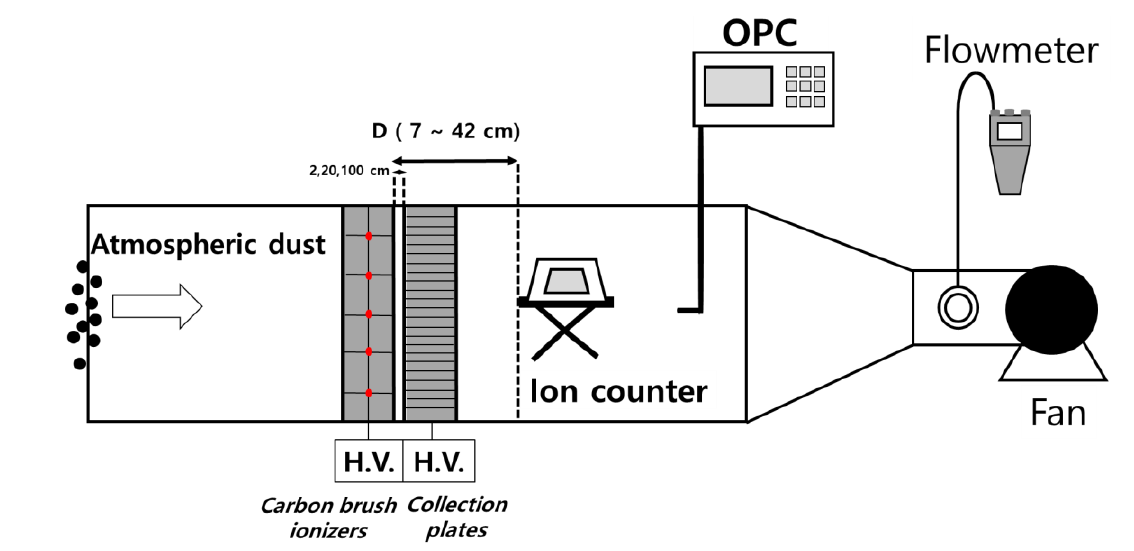
Figure 1. Schematic of collection efficiency measurement experiment.